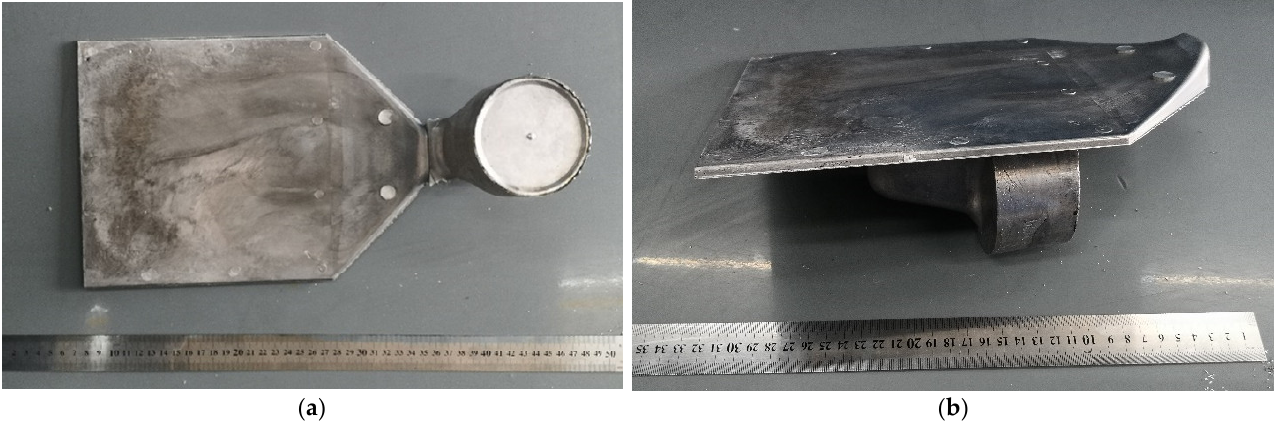
Figure 10. AlSn20Cu alloy billet produced using semi-solid die casting: ( a ) front view, and ( b ) side view.